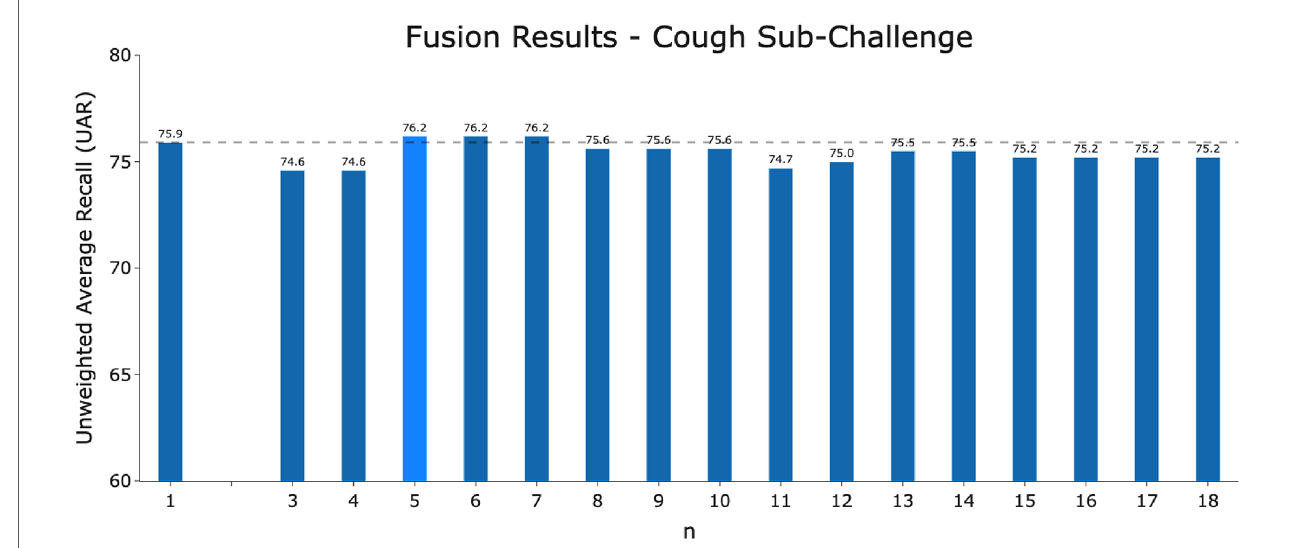
FIGURE A2 The performance of the fusion model of n -best models for the COVID-19 Cough Sub-Challenge using majority voting.